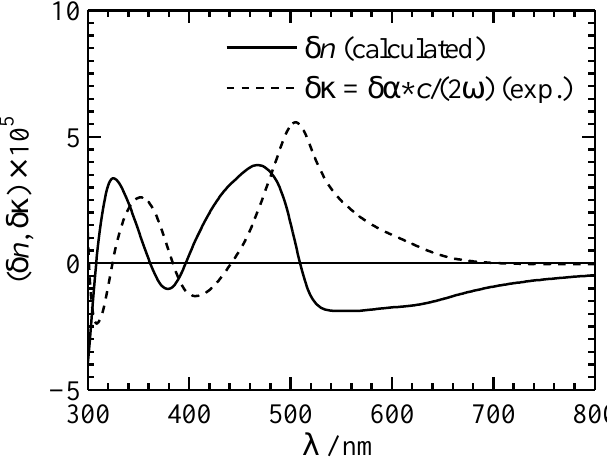
Figure 8. Experimental absorption change (dashed line) and estimated refractive index change (solid) for a 0.88 mM OSO PC solution in the visible spectral range.